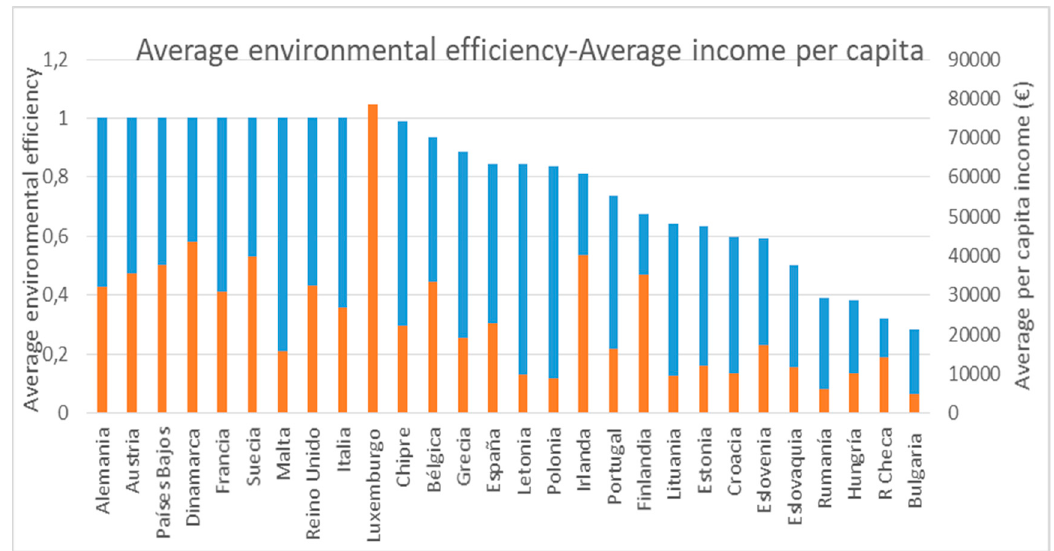
Figure 12. Comparison between the average environmental efficiency obtained with the mean between the DEA Methods 1 and 2 and the average per capita income. Source: self